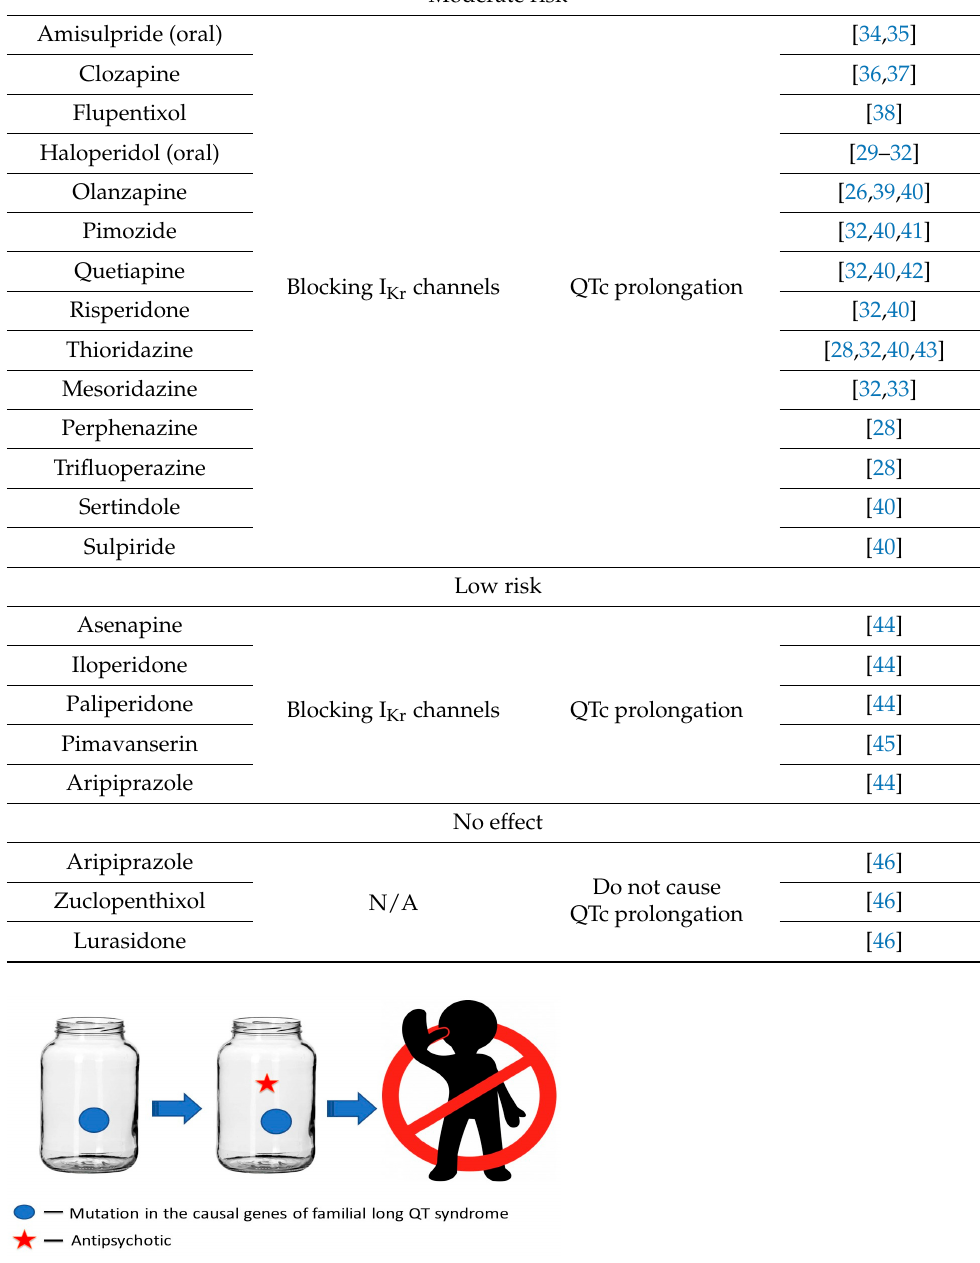
Table 2. Mechanism of action and effect of antipsychotics used to treat schizophrenia on resting heart rate and conduction.